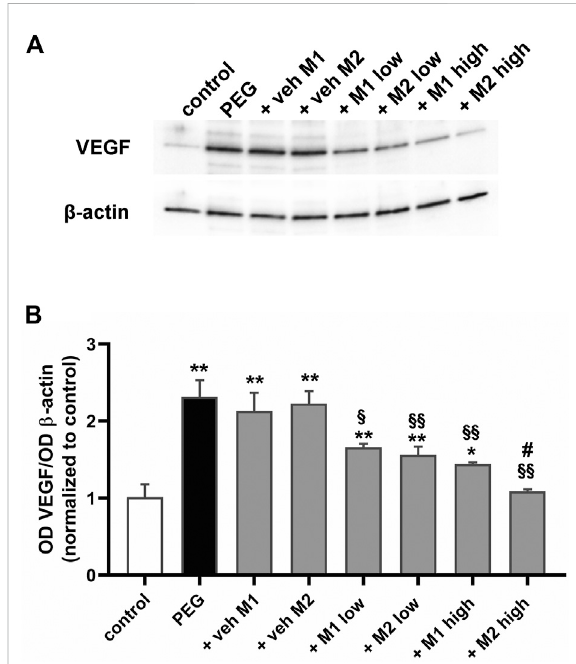
FIGURE 5 Effect of M1 and M2 on VEGF levels. Representative Western blots (A) and densitometric analysis of VEGF (B) in controls, PEG- injected untreated, PEG-injected treated with M1 or M2 vehicles, PEG-injected treated with low or high dose of M1 as well as with low or high-dose of M2. β -actin was used as loading control. Data are plotted as mean ± SEM. Differences among groups were assessed using one-way ANOVA followed by Tukey ’ s multiple comparison post-hoc test (N = 6). * p < 0.01 and ** p < 0.001 vs. control; § p < 0.01, §§ p < 0.001 vs. respective vehicle; # p < 0.05 vs. M1